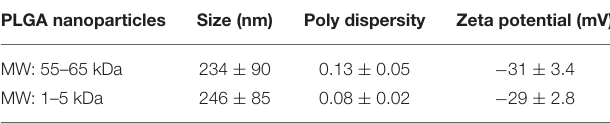
TABLE 1 | PLGA nanoparticle physical